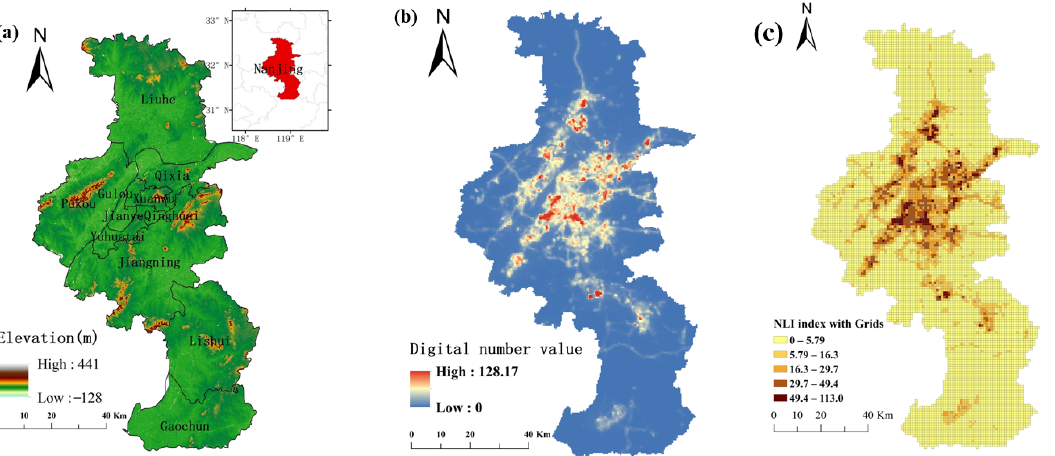
Figure 2. Study region: ( a ) Location of the study region; ( b ) NPP/VIIRS nighttime light data in 2018; and ( c ) The NLI index’s spatial pattern at a grid scale of 1 km.